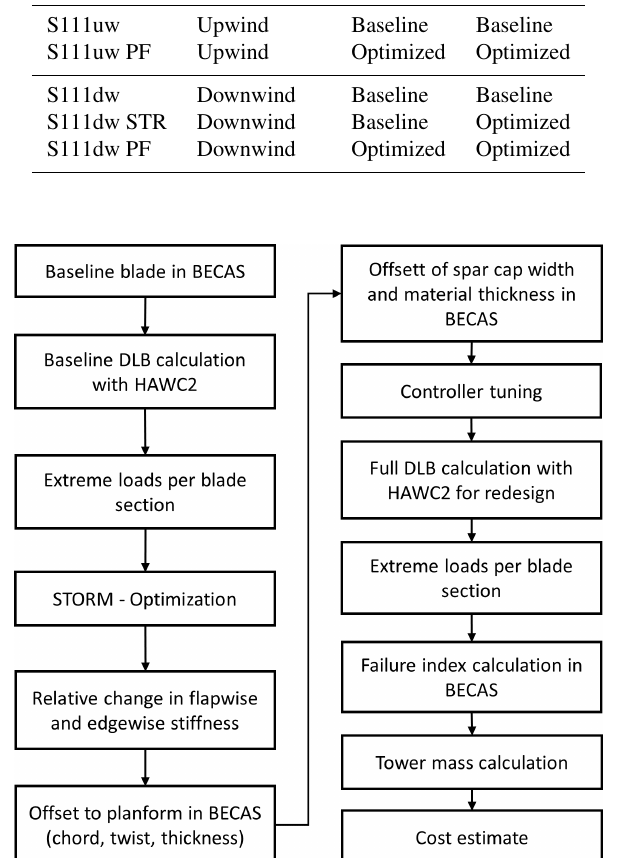
Figure 1. Flow chart of the work flow for design and cost estima-